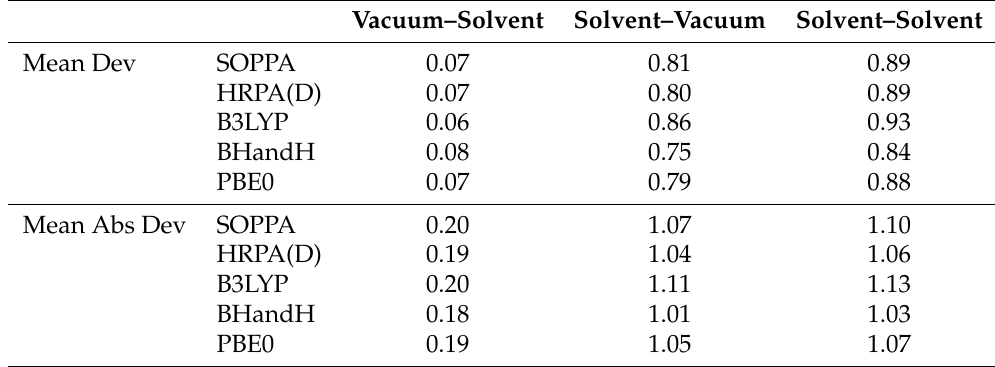
Table 1. Statistical descriptors concerning the magnitude of the solvent effect on the 242 SSCCs in